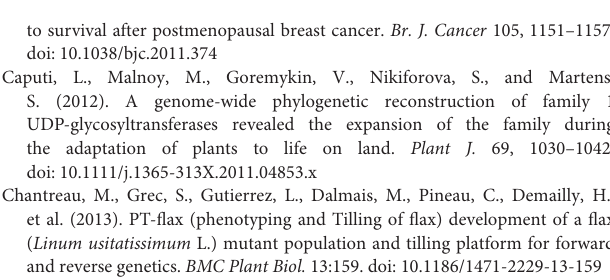
Supplementary Figure 1 | Reverse genetics of 1996 EMS-mutagenized M2 flax lines targeting UGT74S1 gene. (A) genomic region of UGT74S1 used for targeted amplicon resequensing; (B) Schematic representation of the workflow adopted for SNP variants detection in the EMS flax population. Supplementary Figure 2 | UPLC chromatograms of non-hydrolyzed (A) and hydrolyzed (B) lignan extracted from bulked seeds of wild type CDC Bethune and M2 families 1230 and 2340, identified to carry nonsense mutations in UGT74S1 . (A) lignan macromolecule profiles for the wild type CDC Bethune, M2 family 1230 predicted to have a premature stop codon at amino acid 205, and M2 family 2340, heterozygous for SNP-1859 and predicted to encode a wild type allele of UGT74S1 gene and a mutant one with a premature stop codon at amino acid 355. Note the narrower width of the lead peak in family 1230 compared to CDC Bethune as indicated by the two arrows and additional peaks on the lead peak in family 2340 as indicated by stars compared to CDC Bethune and M2 family 1230. The patterns of both M2 families also displayed additional and higher peaks (indicated by stars) in other parts of the chromatograms compared to CDC Bethune. (B) UPLC chromatograms of the hydrolyzed lignan complex from CDC Bethune, M2 families 1230 and 2340 showing peak height variations for SDG and phenolic acid glucosides encountered in the complex lignan polymers. Supplementary Figure 3 | Summary of mutational effects on lignan glucoside species production in UGT74S1 flax mutant lines. Number of stars represents the relative amount of lignan species; HCA, hydroxycinnamic